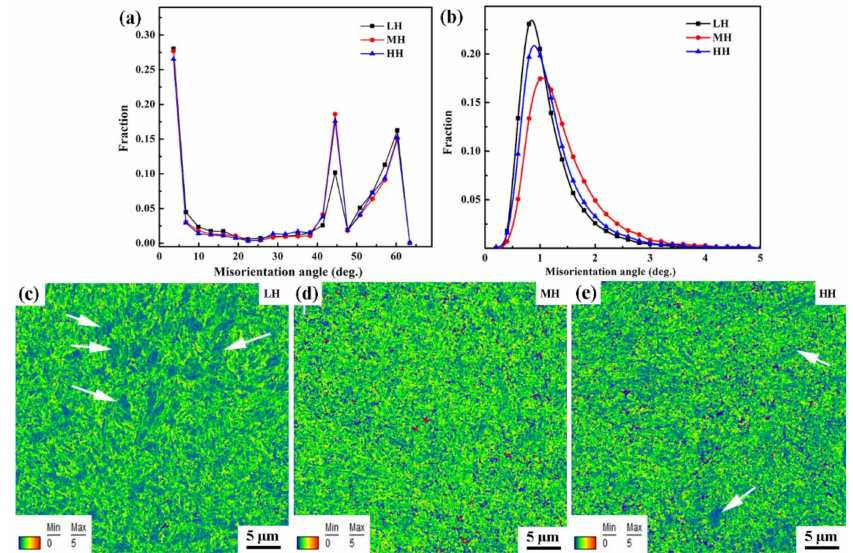
Figure 6. ( a ) Misorientation distributions of the as-built SLM-processed LH, MH, and HH. ( b ) The corresponding low misorientation angle distributions of ( a ). ( c – e ) The corresponding KAMs maps of ( b